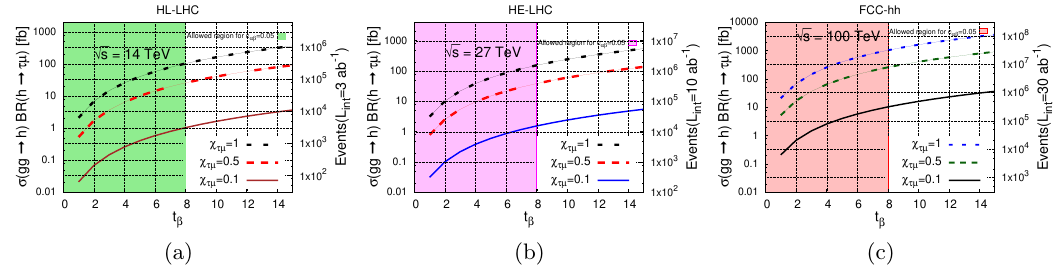
Figure 7 . (a) Scenario SA , (b) Scenario SB , (c) Scenario SC . Left axis: (cid:27) ( gg as a function of t (cid:12) for (cid:31) (cid:28)(cid:22) =0.1, 0.5, 1. Right axis: events- t (cid:12) plane. The dark area corresponds to the allowed region. See table